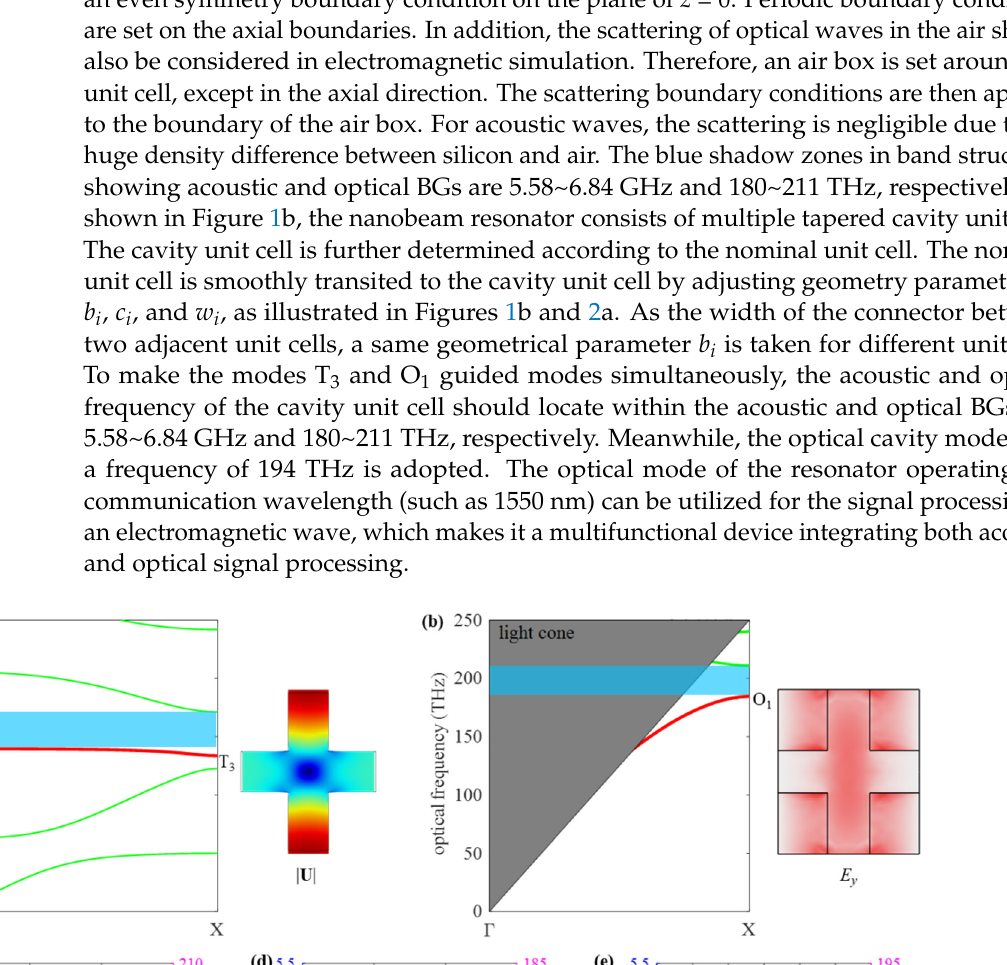
Figure 4. Frequency contours varying with geometrical parameters a 1 and c 1 for ( a ) mode T 3 , ( b ) mode O 1 .